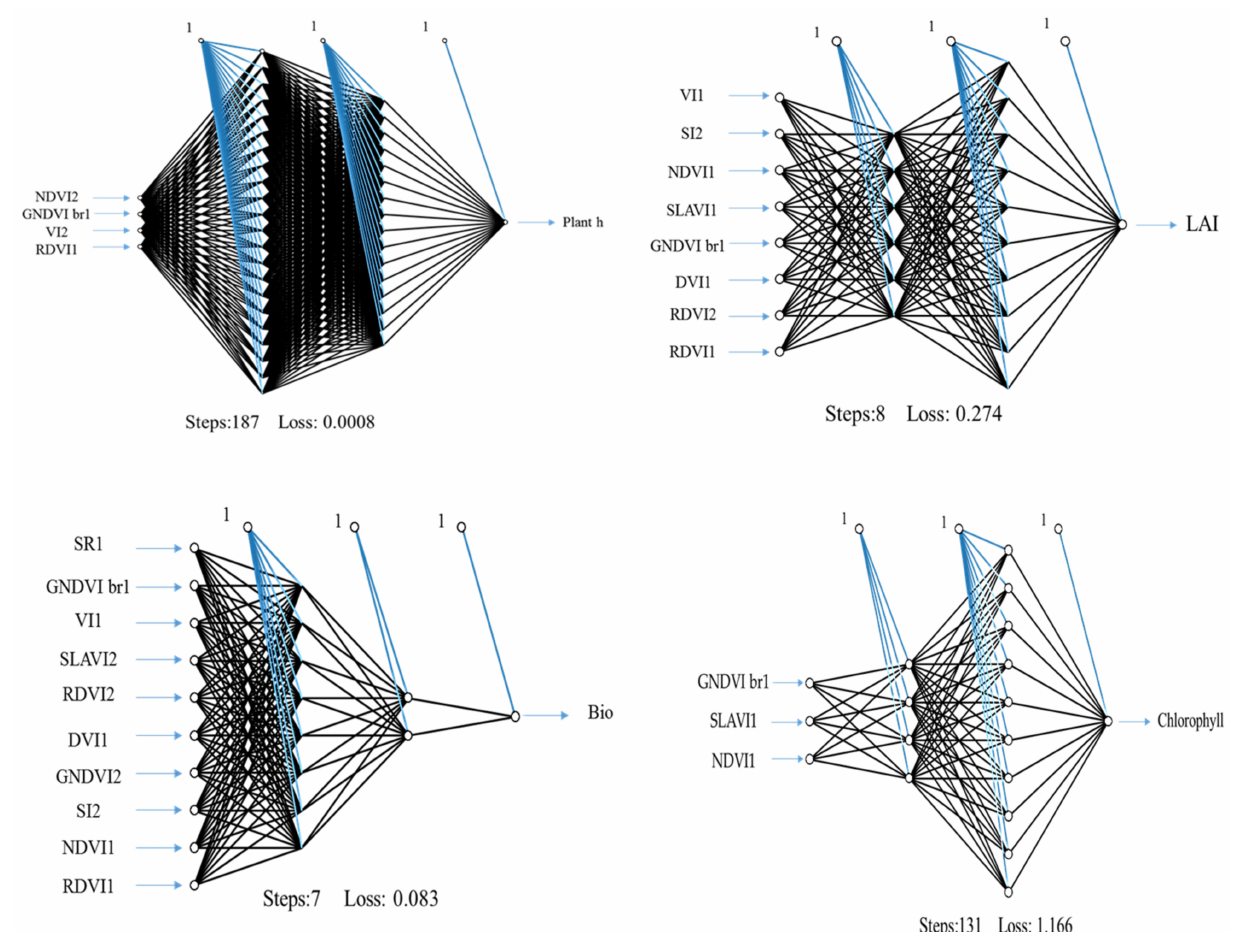
Figure 3. Neural network topology with the best-combined V-SRIs extracted from in situ spectrometry and satellite